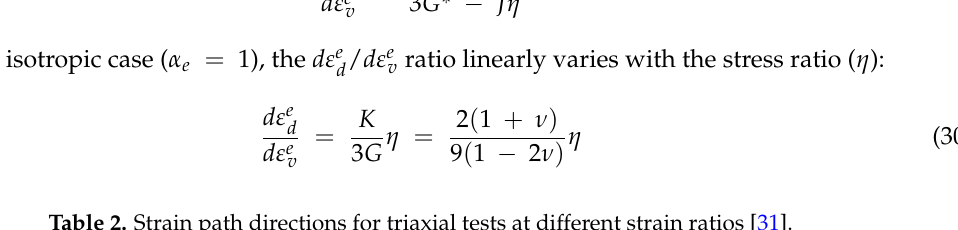
Table 2. Strain path directions for triaxial tests at different strain ratios [31].